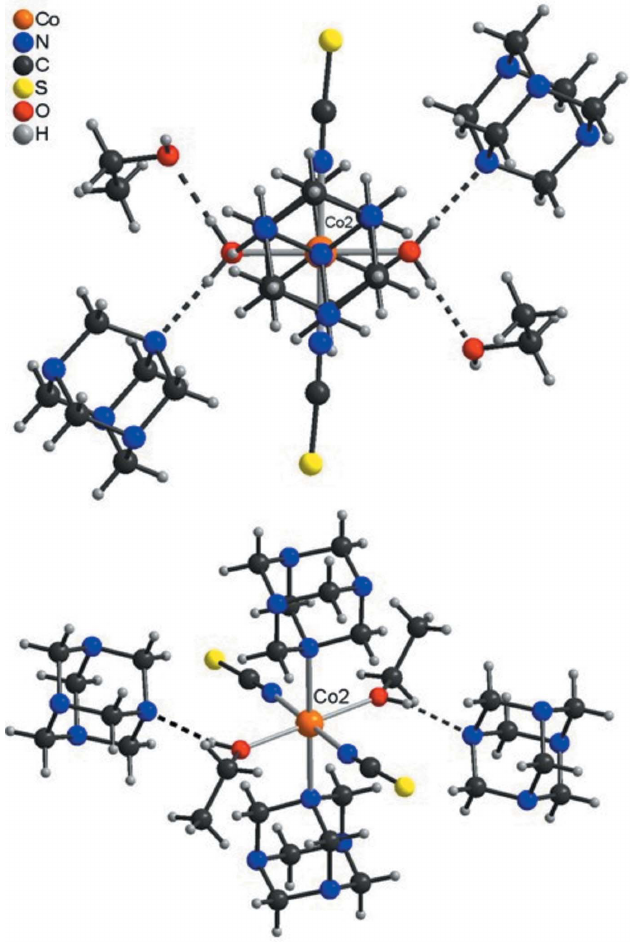
Figure 4 View of the two different coordinations of Co2 in compound 1 with H 2 O (top) and ethanol (bottom) with intermolecular hydrogen bonding shown as dashed lines.